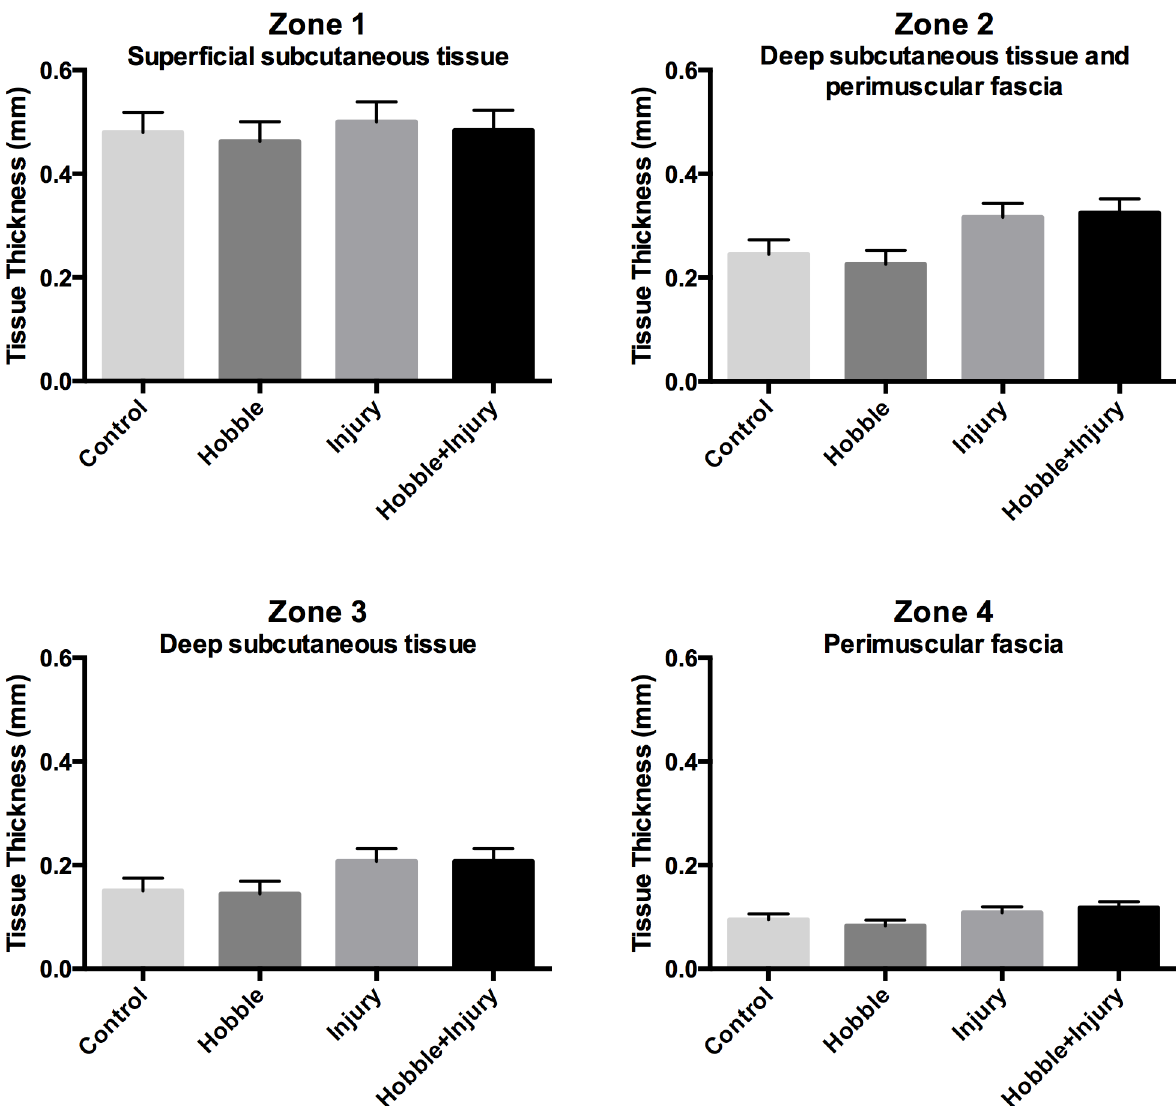
Fig 6. Ultrasound measurements of tissue thickness. The tissue thickness in four Zones (See Fig 3 for Zone locations) was measured at the L3-4 vertebral level on the non-intervention side. There was no significant difference in the combined thickness of dermis and superficial connective tissue (Zone 1) among groups ( p = 0 . 60) . The thickness of Zone 2 (deep subcutaneous tissue and perimuscular fascia), Zone 3 (deep subcutaneous tissue) and Zone 4 (perimuscular fascia) all were significantly greater in the injured pigs compared with the other groups (ANOVA, main effect of injury for p = .007 (Zone 2), p = .026 (Zone 3) p = .04 (Zone